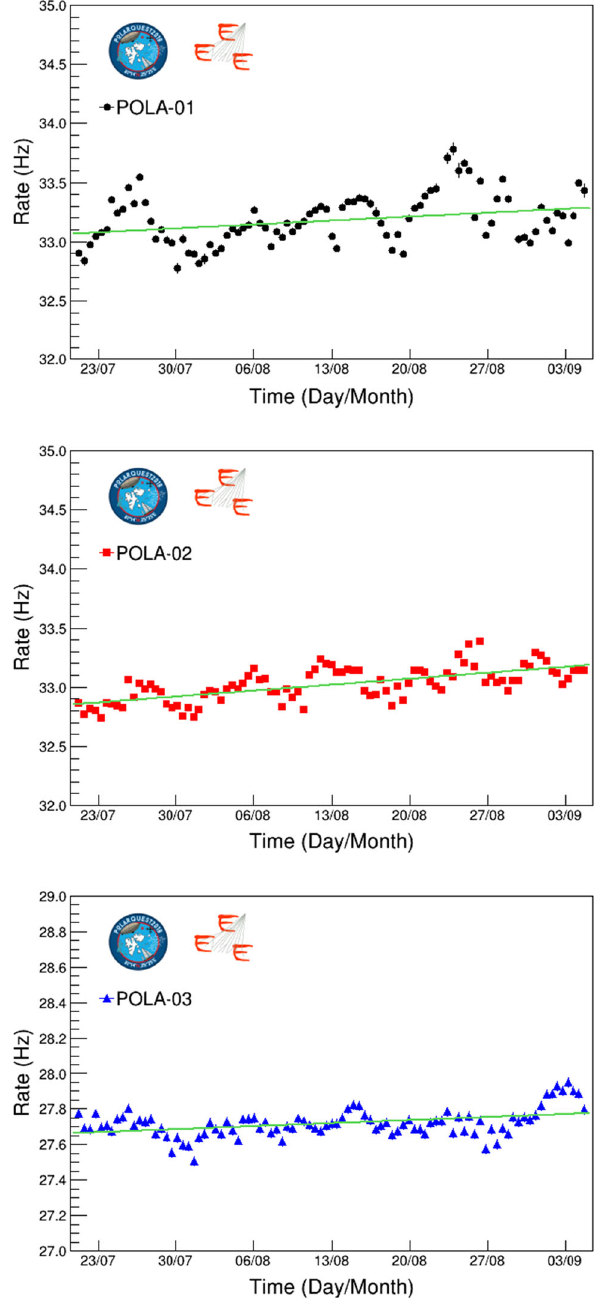
Fig. 26 Top: Rate measured by POLA-01 vs. geographical latitude, divided by the average rate. Bottom: Rate measured by POLA-01 vs. geomagnetic latitude, divided by the average rate ticular effects do not depend on time or POLA-01 latitude, they do not need to be corrected for.